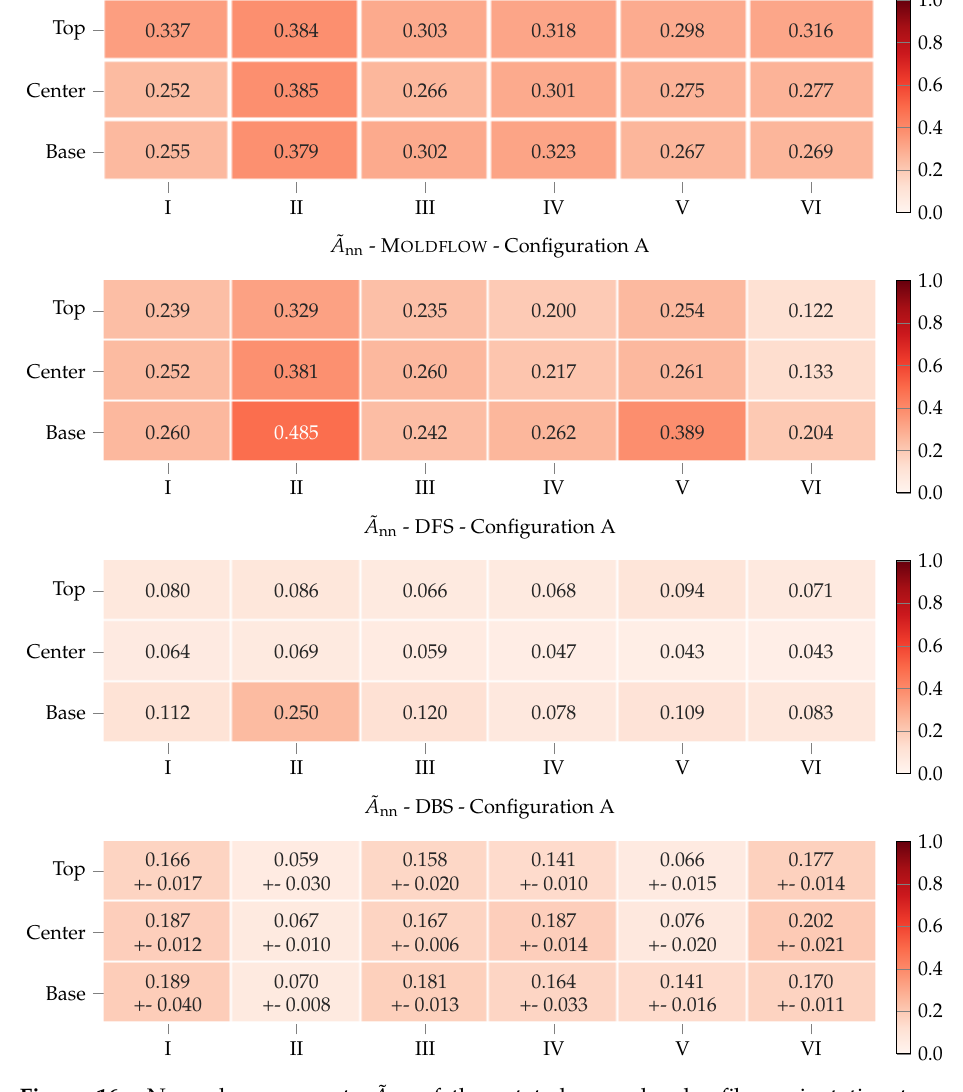
Figure 16. Normal components ˜ A nn of the rotated second-order fiber orientation tensor for Configuration A according to M OLDEX 3D, M OLDFLOW , the Direct Fiber Simulation and the Direct Bundle Simulation. The normal orientation component ˜ A nn should be small because fiber bundles are constrained by the plane of the surrounding